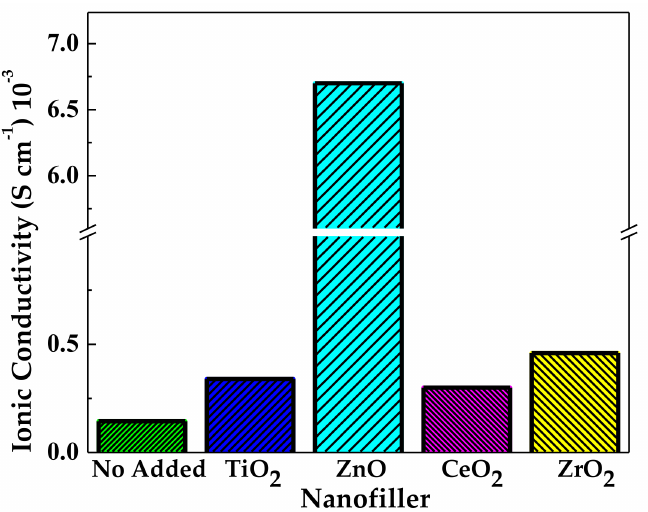
Figure 7. Plot of nanofiller versus ionic conductivity ( × 10 − 3 ) for nanocomposite polymer electrolyte based on PVDF-co-HFP and zinc triflate salt. Prepared from data in [57,90–93]. 3. The Poly(ethylene Oxide)’s Based Nanocomposite Polymer